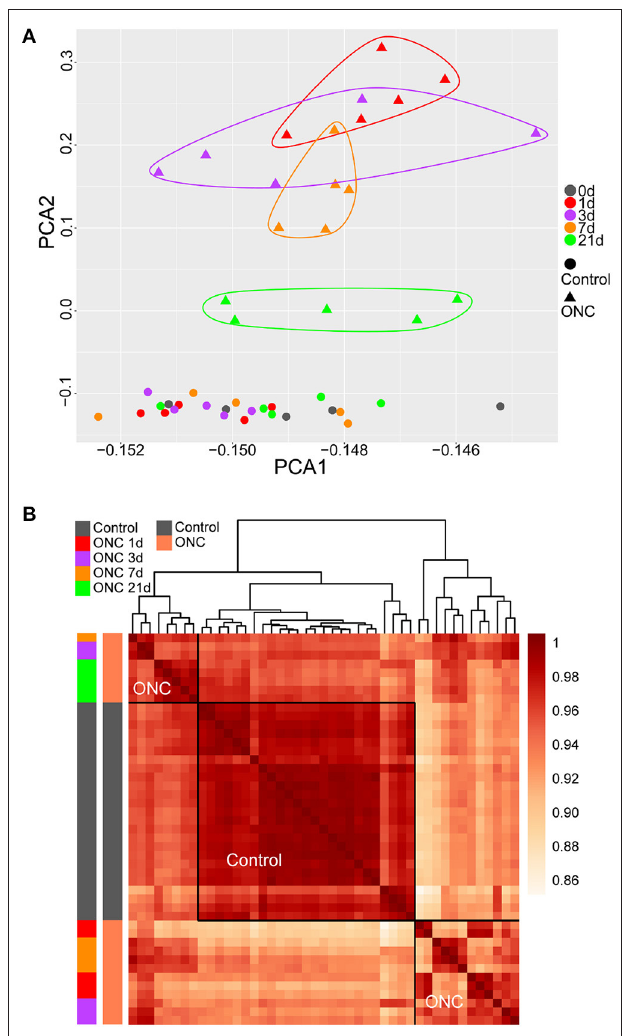
FIGURE 1 | PCA and sample clustering revealed temporal changes following ONC. (A) PCA of 45 ONH samples. The time points following ONC are labeled with different colors. Uninjured control ONHs are labeled with circles. The injured ONHs are labeled with triangles. (B) Heatmap of unbiased hierarchical clustering of pairwise correlations among all 45 samples. The dark red in the heatmap represents Pearson’s correlation coefficient of transcriptomes among pairs of samples in all combinations. The traits of all samples are labeled with different colors. The horizontal and vertical frames are symmetrical. All the uninjured control samples were clustered together. ONH, optic nerve head; PCA, principal component analysis; ONC, optic nerve